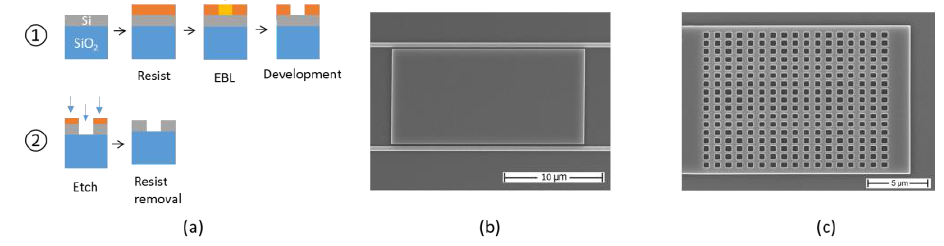
Figure 3. ( a ) Flow diagram of the fabrication process; ( b ) SEM image of the fabricated rectangular resonator; ( c ) TM grating coupler.